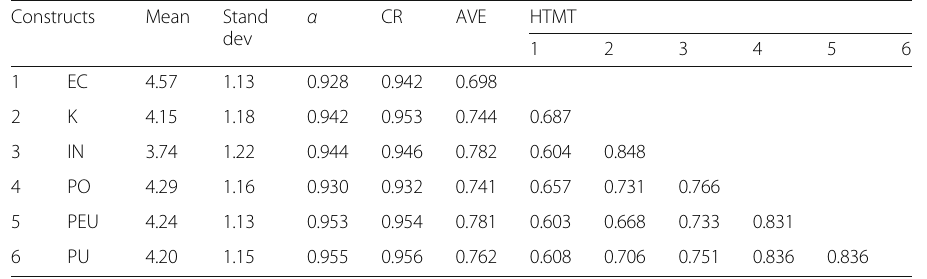
Table 1 Measurement model assessment Constructs